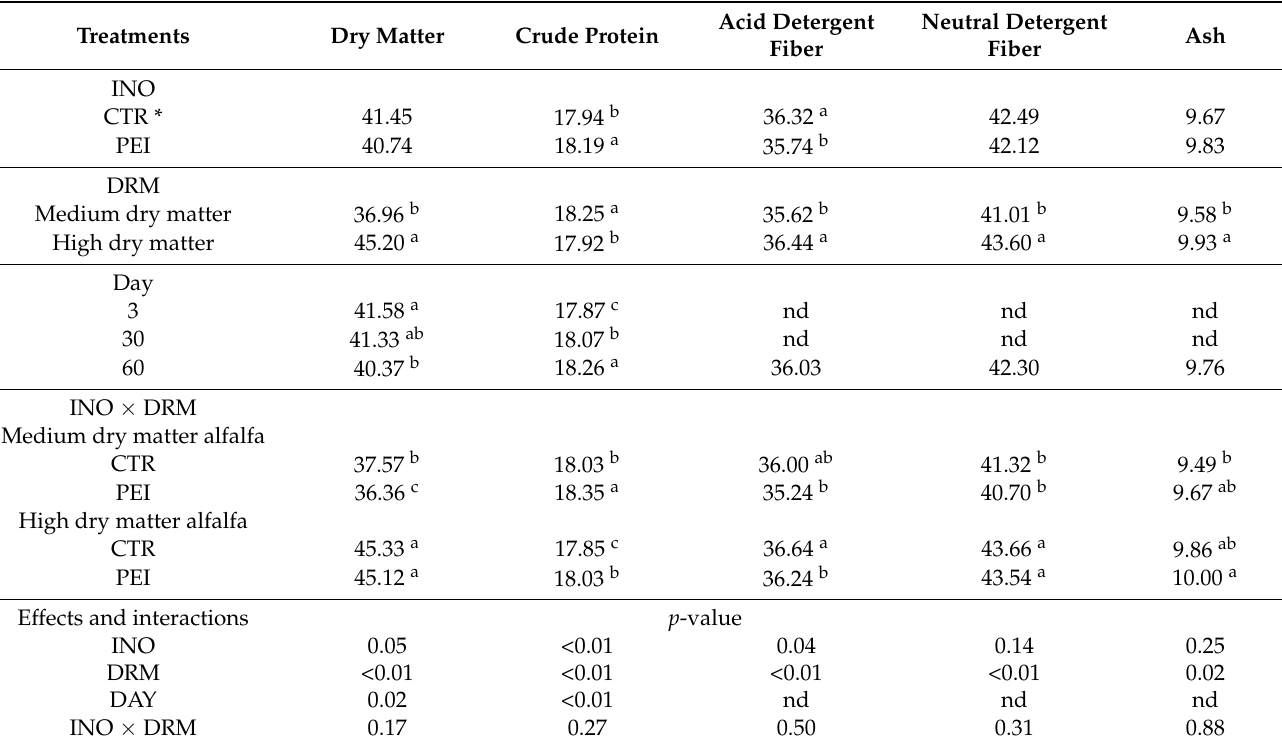
Table 4. The DM and chemical analysis (% DM basis unless stated otherwise) of alfalfa silage ensiled for 3, 30 and 60 d. Means shown for main effects and two-way interaction when significant. There were no significant INO × DAY or DRM × DAY interactions (data not shown). (ADF, NDF and ash data only for day